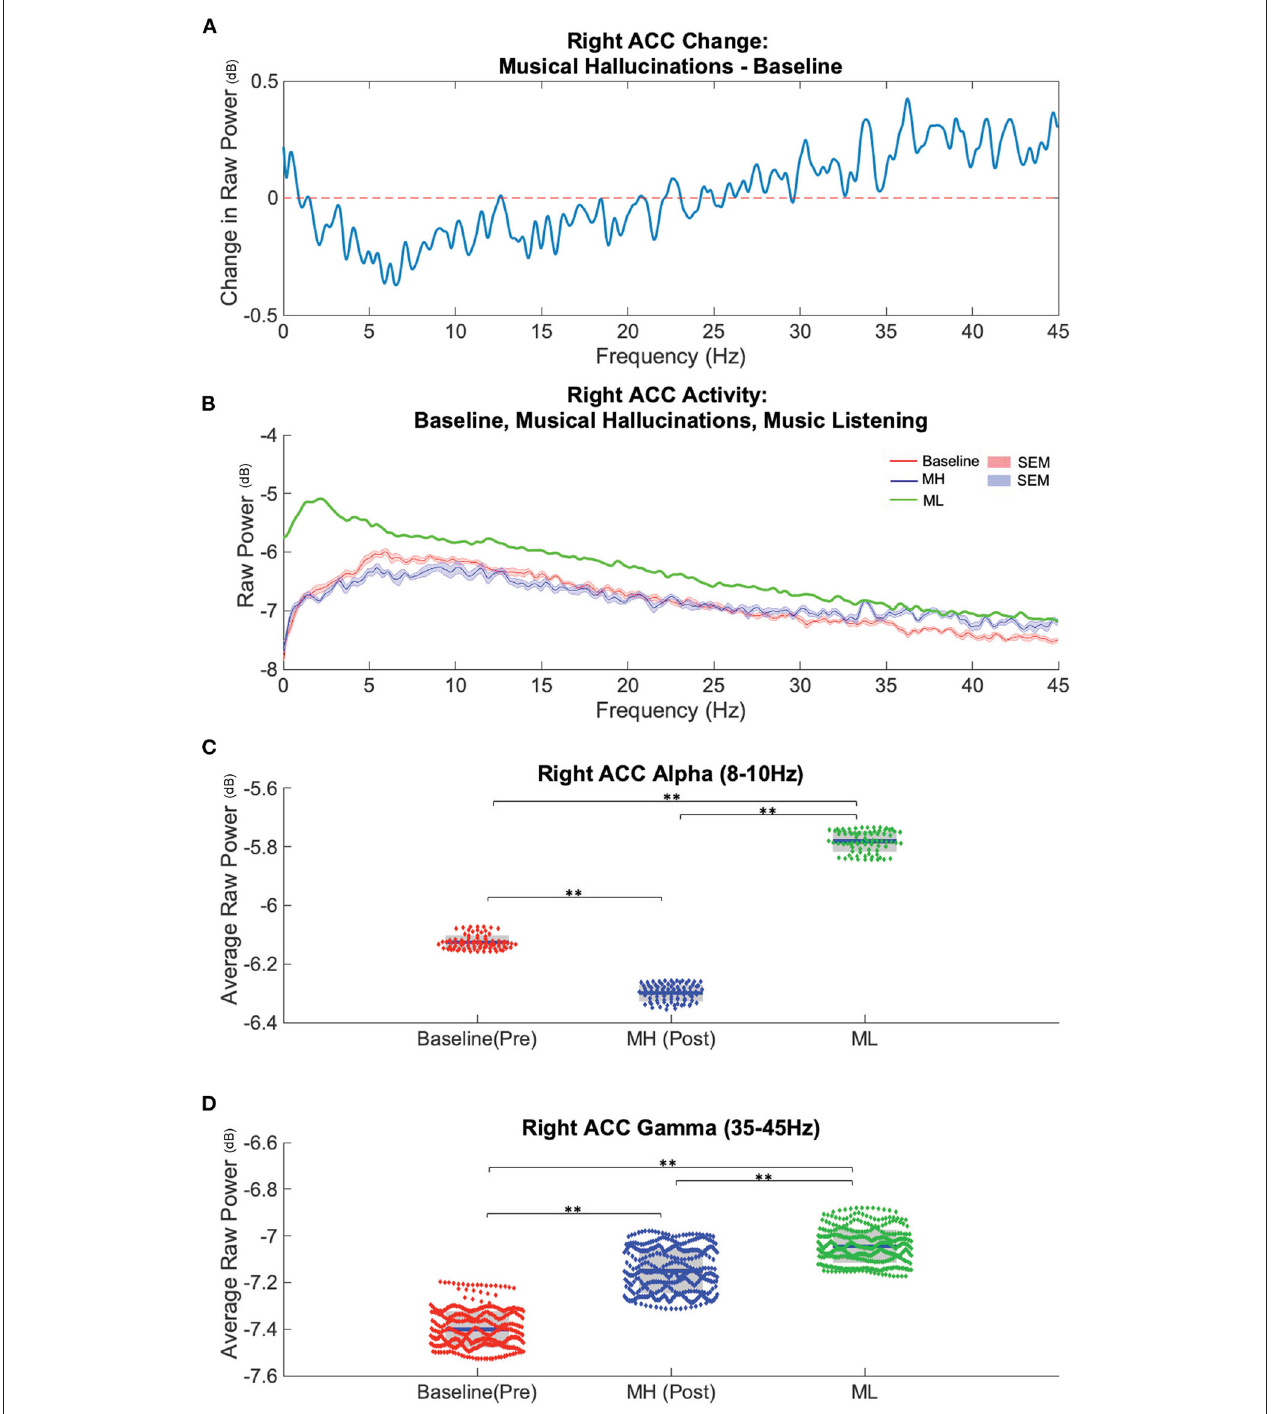
FIGURE 3 | Spectral power in Right ACC distinguishes baseline (pre-MH), musical hallucination (MH), and music listening (ML) conditions. (A) Average difference between baseline power ( n = 8 recordings) subtracted from the post-MH onset ( n = 8) conditions across analyzed frequencies (0–45Hz) in ACC. (B) Average power spectra and SEM during baseline (red), MH (blue) and music listening conditions ( n = 1) (green). (C) Alpha band power, (8–10Hz), was lower during MH and higher during ML compared to baseline (blue bar = mean, grey boxes = 95% confidence interval). (D) Gamma band power, (35–45Hz) was higher during MH and ML compared to baseline. **significant difference ( p <